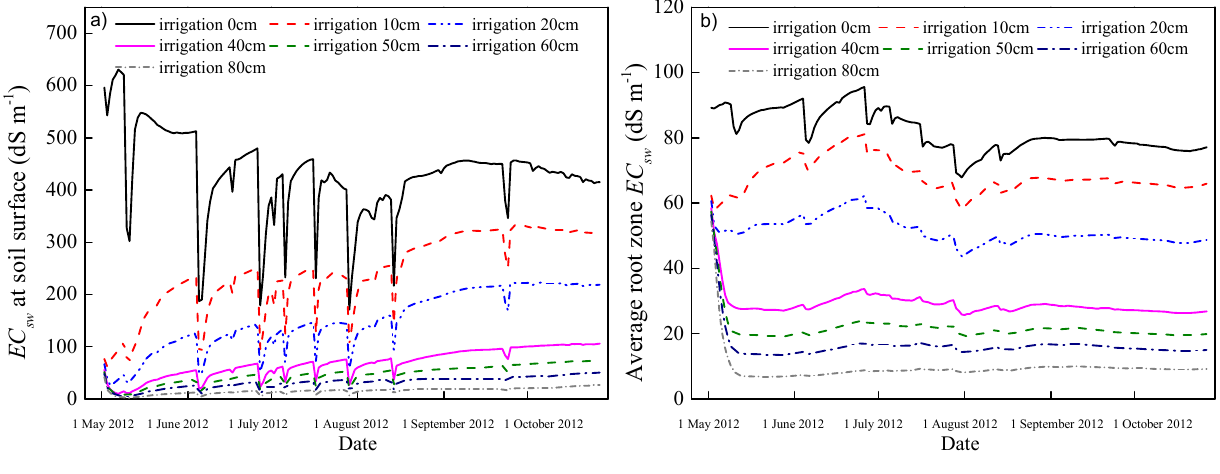
Figure 9. Temporal changes of soil salinity at the soil surface ( a ) and the averaged root zone electrical conductivity as affected by irrigation amount ( b